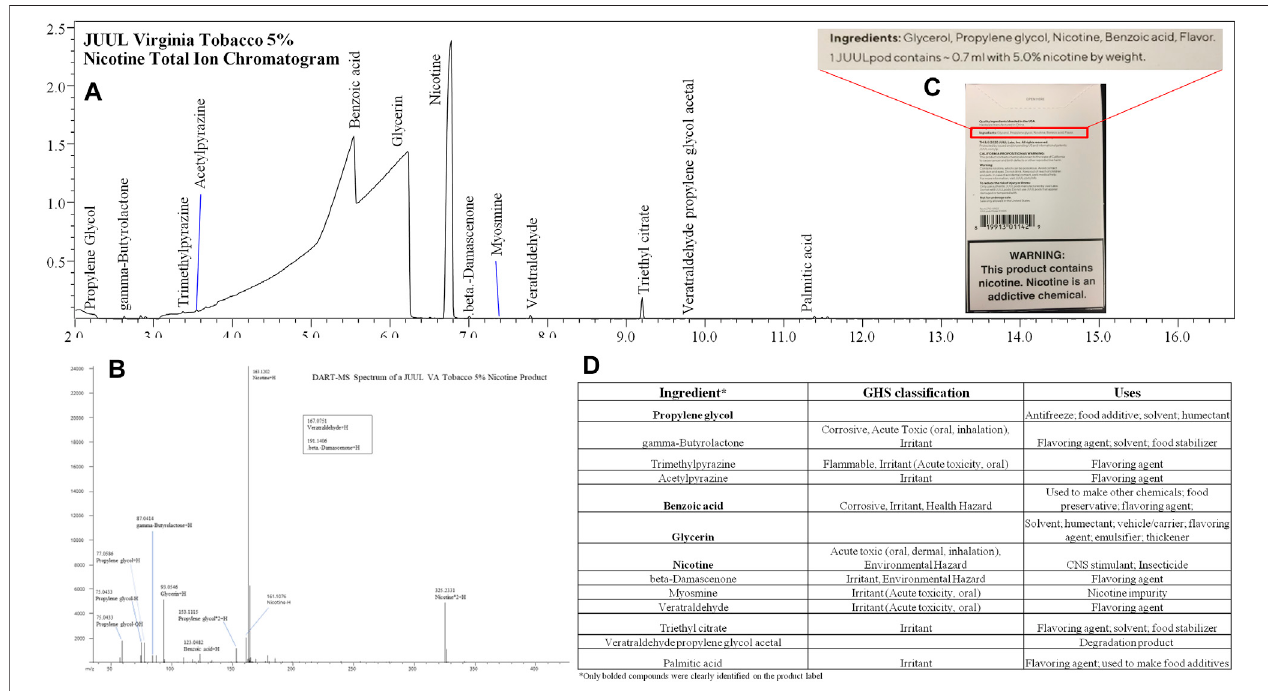
FIGURE 7 | (A) JUUL Virginia Tobacco 5% Nicotine Total Ion Chromatogram, (B) DART-MS Spectrum, (C) Packaging, and (D) GHS classi fi cation and Uses of Identi fi ed Ingredients. This exempli fi es the typical results of product screening.